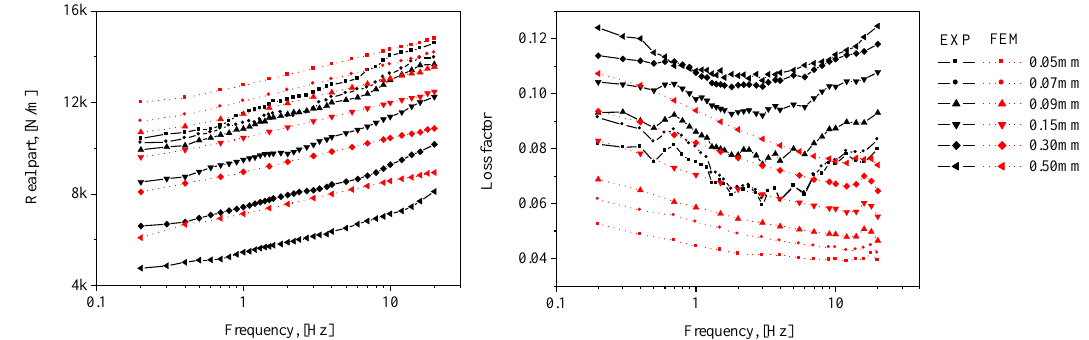
Figure 13. Comparison between measured and calculated complex stiffness of inflated rubber diaphragm k* d ; real part: Re[ k * d ], loss factor: Im[ k * d ] / Re[ k * d ].